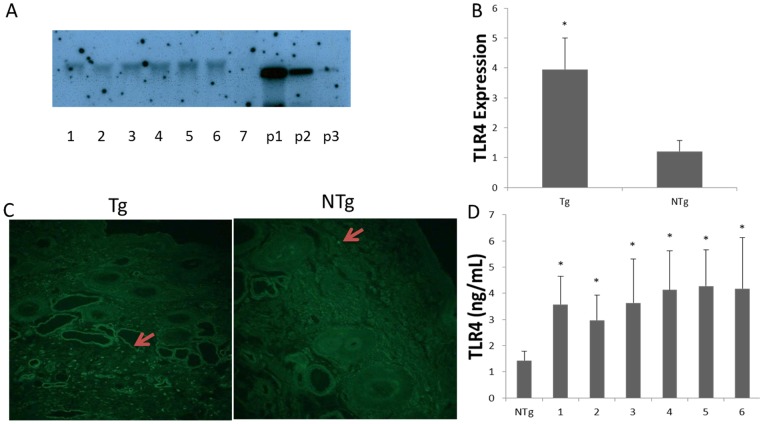
Production of TLR4 overexpression transgenic sheep by microinjection.A) Southern blot analysis. Samples from positive individuals (numbered 1, 2, 3, 4, 5, and 6) are shown with 7 as a negative control. p1, p2 and p3 are samples of transgenic vectors, here used as positive controls. B) Transcription of TLR4 in transgenic sheep. C) immunohistochemical staining showed more TLR4 expression in transgenic animals (100×). Sections were stained with TLR4-FITC (green). D) Protein levels of TLR4 in transgenic sheep. Tg  =  transgenic sheep, NTg  =  non-transgenic sheep. *Different letters indicate significantly different values (P<0.05).